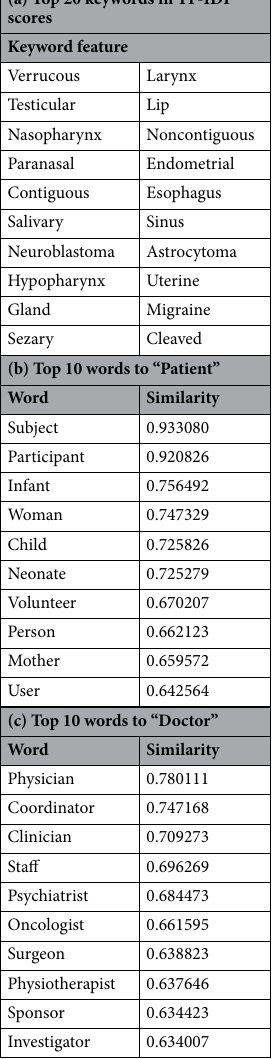
Table 2. Top 20 keywords with the largest TF-IDF scores (a), and the top 10 words and their cosine similarities to “Patient” (b) and “Doctor” (c) determined by using trained Doc2Vec word embedding